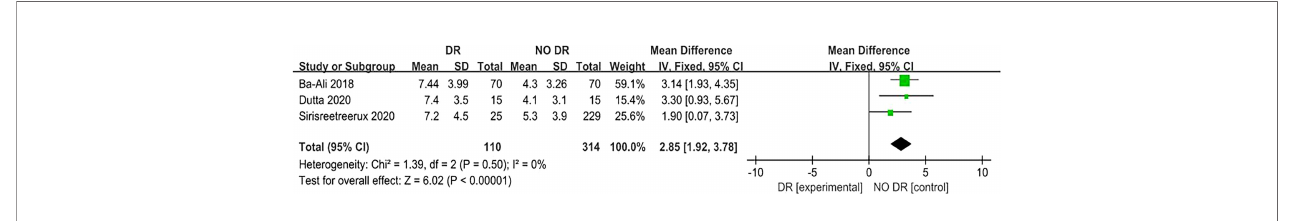
FIGURE 5 | Forest plot of PSQI score and DR risk